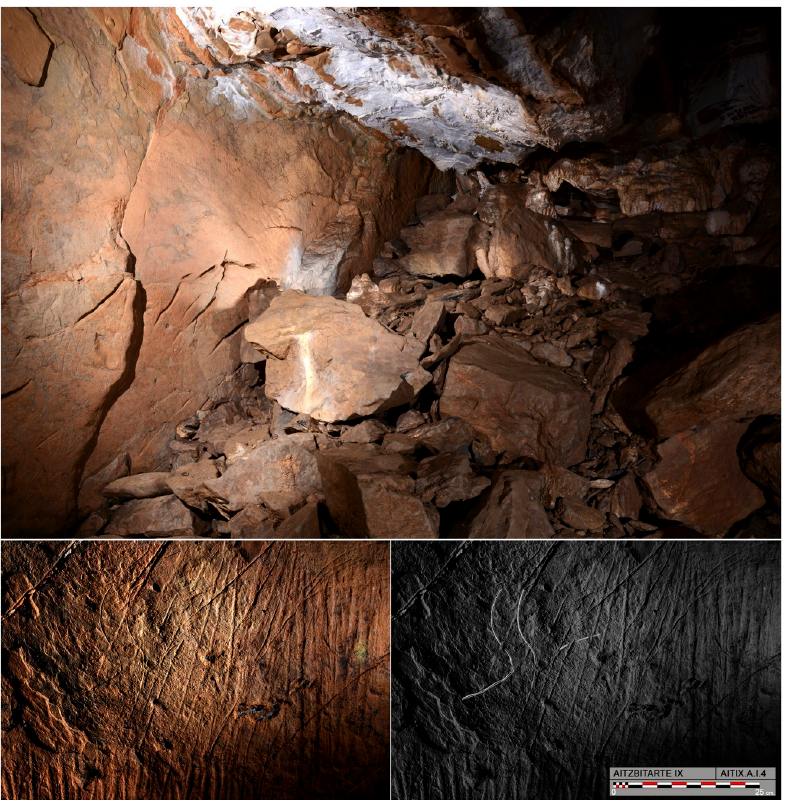
Fig 13. The engravings from Aitzbitarte IX. Top: Collapsed passage in Aitzbitarte IX with the decorated panel on the left. Bottom: Photograph and tracing of the engraved bison head A.I.4 in Aitzbitarte IX (O. Rivero and D. Garate).